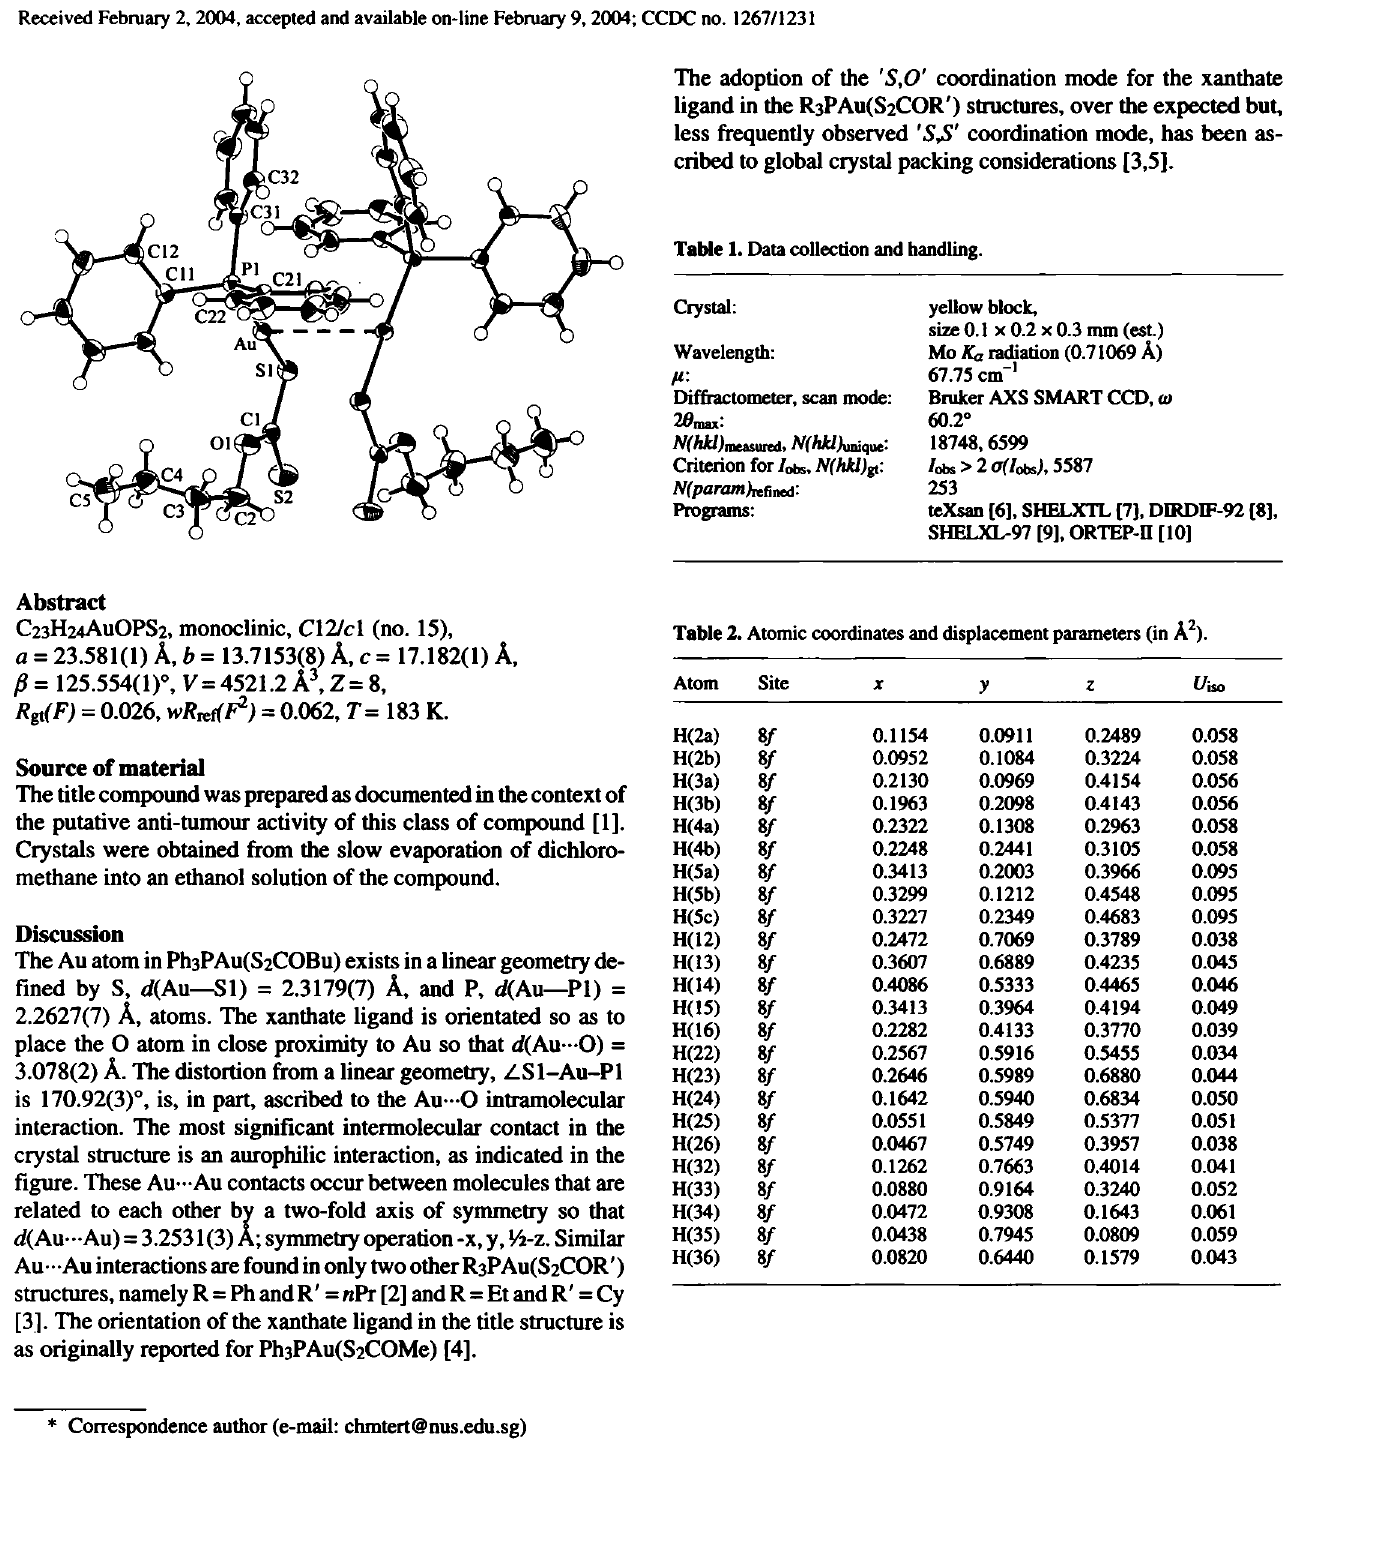
Table 1. Data collection and handling.